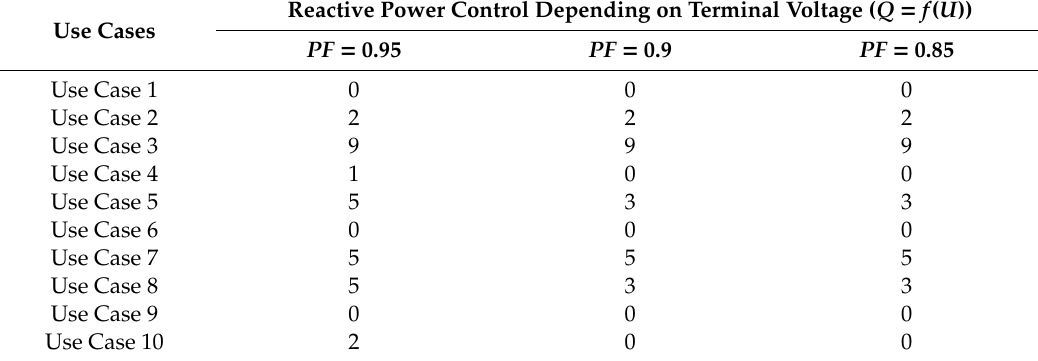
Table A10. Reactive power control depending on terminal voltage: Voltage